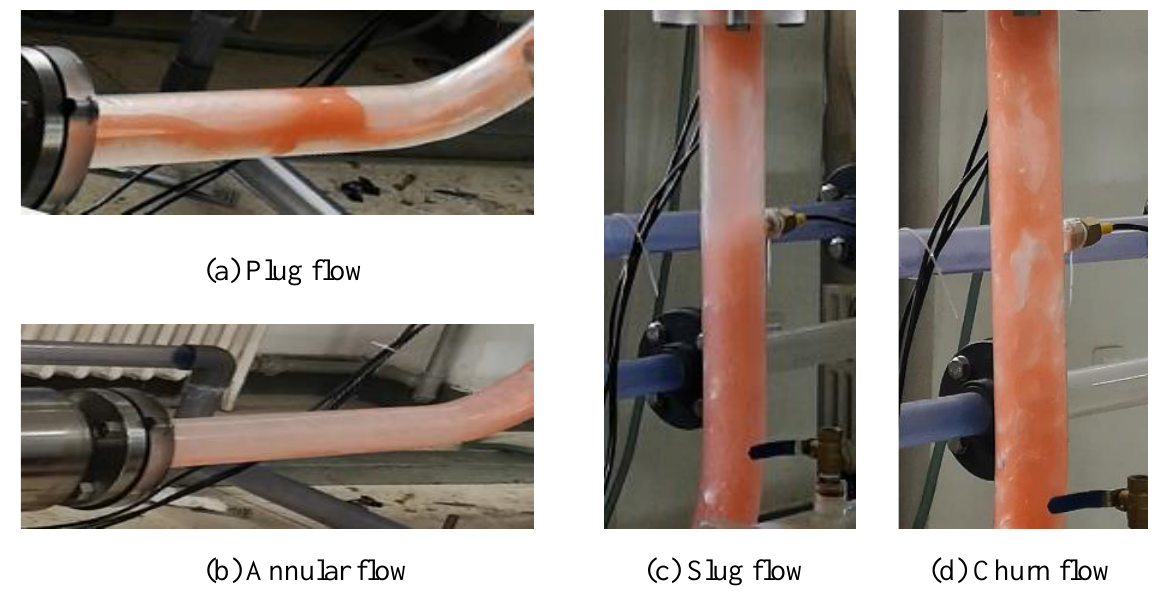
Figure 5. Instantaneous flow patterns observed in the experiments in the horizontal and vertical sections: ( a ) plug flow, Fr m = 0.368, u sg /u sm = 0.25, ε w = 0.5; ( b ) annular flow Fr m = 0.105, u sg /u sm = 0.50, ε w = 0.5; ( c ) slug flow, Fr m = 0.216, u sg /u sm = 6, ε w = 0.1; ( d ) churn flow, Fr m = 0.368, u sg /u sm = 4, ε w = 0.1